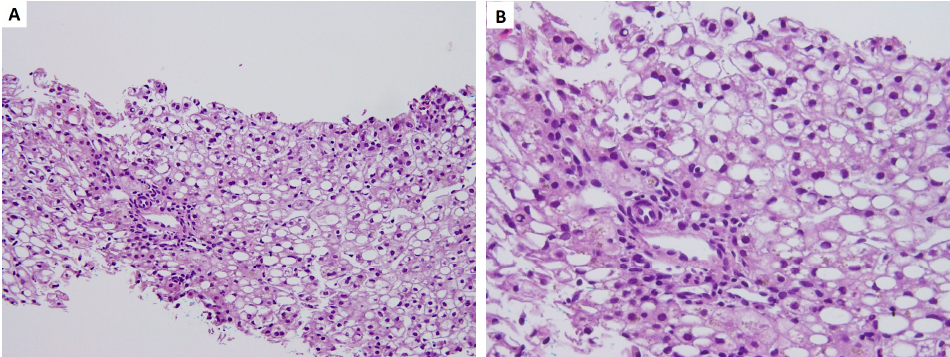
Figure 2. Hematoxylin and eosin staining showed that the lobules marked macrovesicular and microvesicular fatty metamorphosis with no spotty necrosis. ( A ) as observed under 200× and ( B ) as observed under 400×.